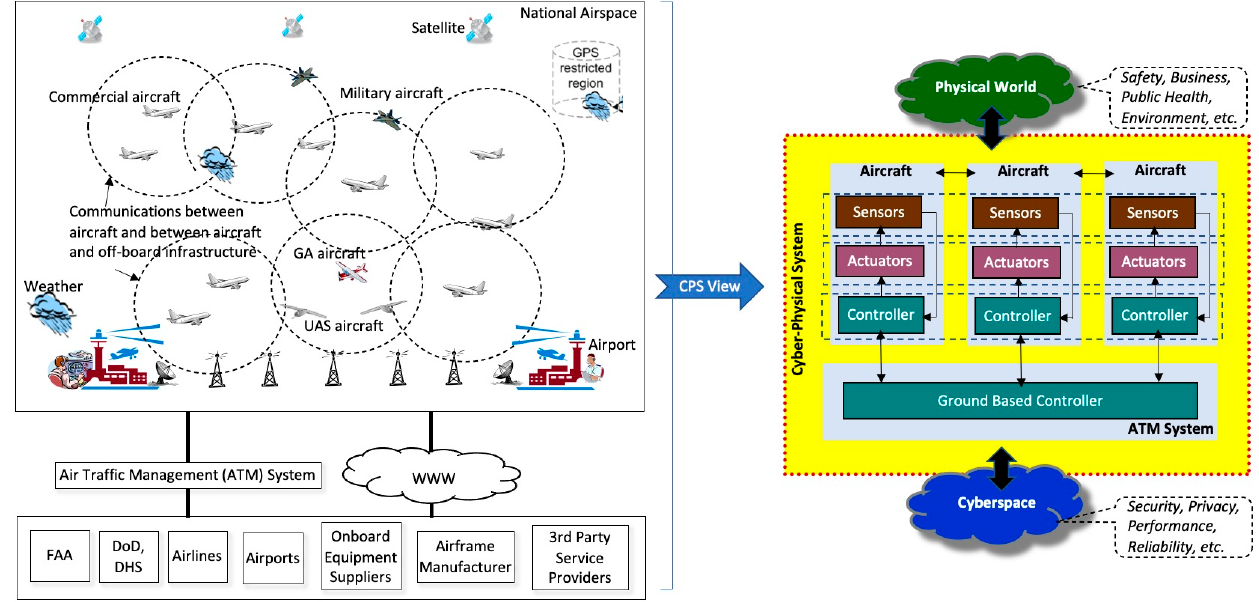
Figure 3. Illustration of a future airspace shared by different aircraft envisioned as a